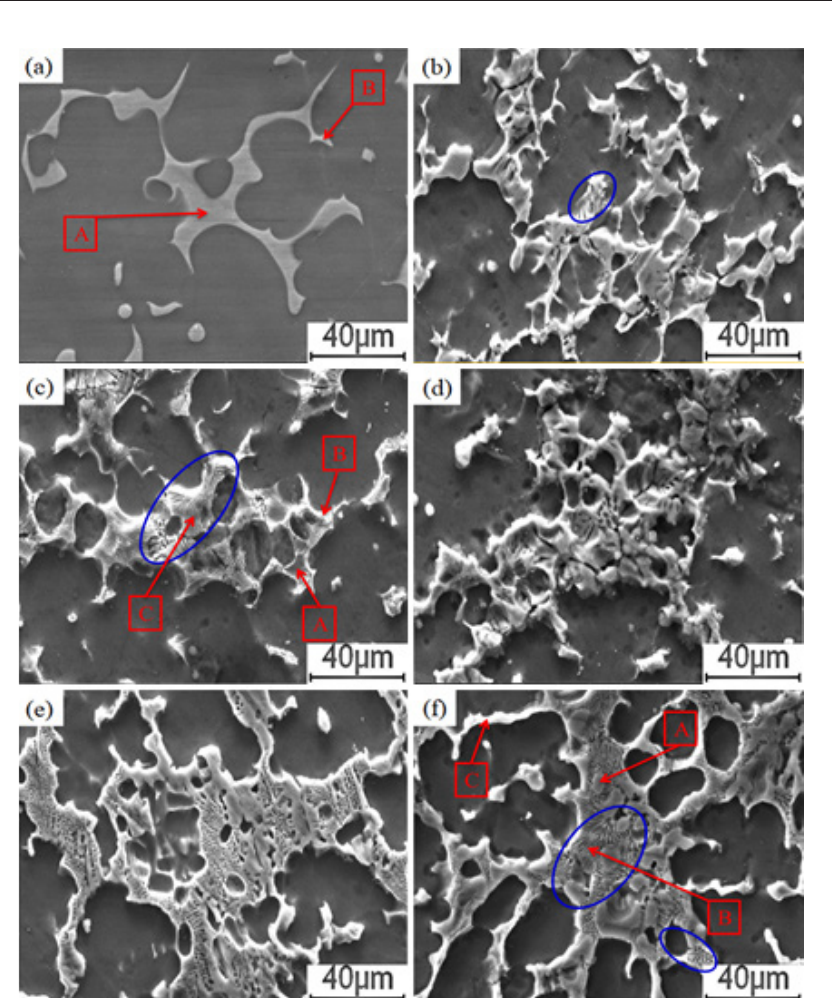
Figure 4 - SEM high-magnification micrographs of the as-cast alloys: (a) ZA120 alloy; (b) ZA122 alloy; (c) ZA124 alloy; (d) ZA126; (e) ZA128; (f) ZA1210.